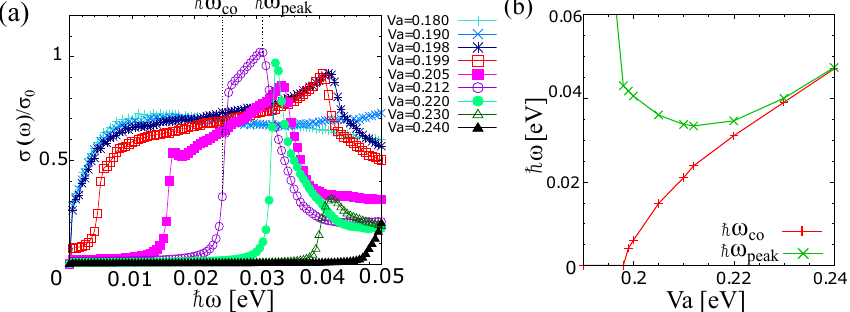
Figure 2. The optical conductivities divided by the universal conductivity σ 0 = π e 2 /2 h [38] for V a = 0.180,0.190,0.198,0.199,0.205,0.212,0.220,0.230,0.240 (a) . ω CO and ω peak for V a = V c 2 a = 0.212 are shown in ( a ). V a -dependences of ω CO and ω peak are shown in ( b ). A characteristic peak structure is found near the CO transition in the extended Hubbard model describing the organic Dirac electron system α -(BEDT-TTF) 2 I 3